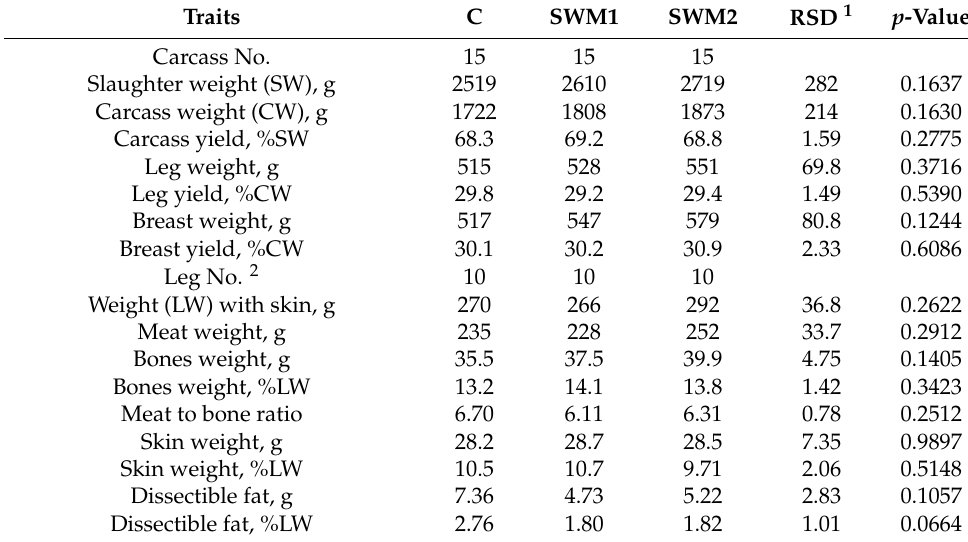
Table 5. Effect of the dietary inclusion either with 0% (Control) or 4% of defatted silkworm ( Bombyx mori L.) meal during starter (SWM1) or grower and finisher (SWM2) phase on carcass traits and chicken leg dissection yields.